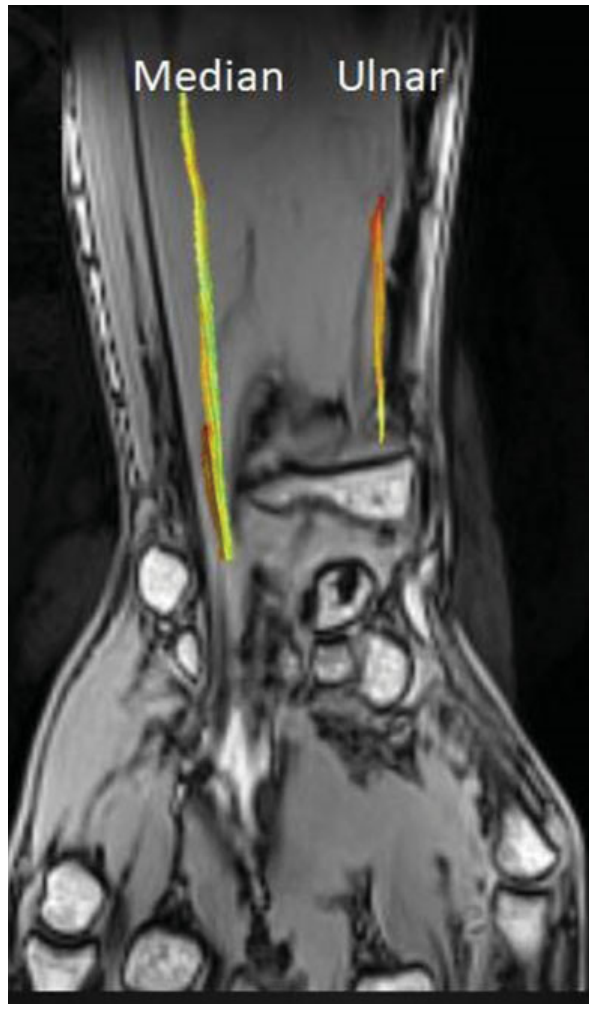
Fig. 6 Three-dimensional image illustrates fi ber tracking of the median nerve and ulnar